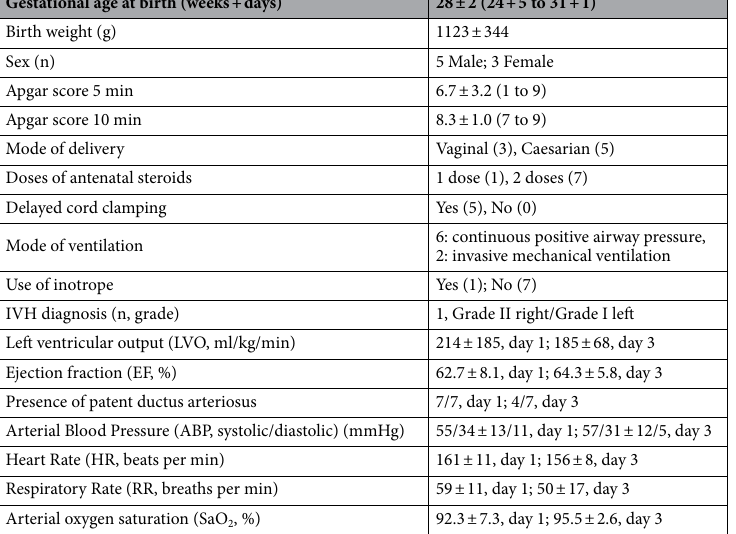
Table 1. Patient demographics and clinical